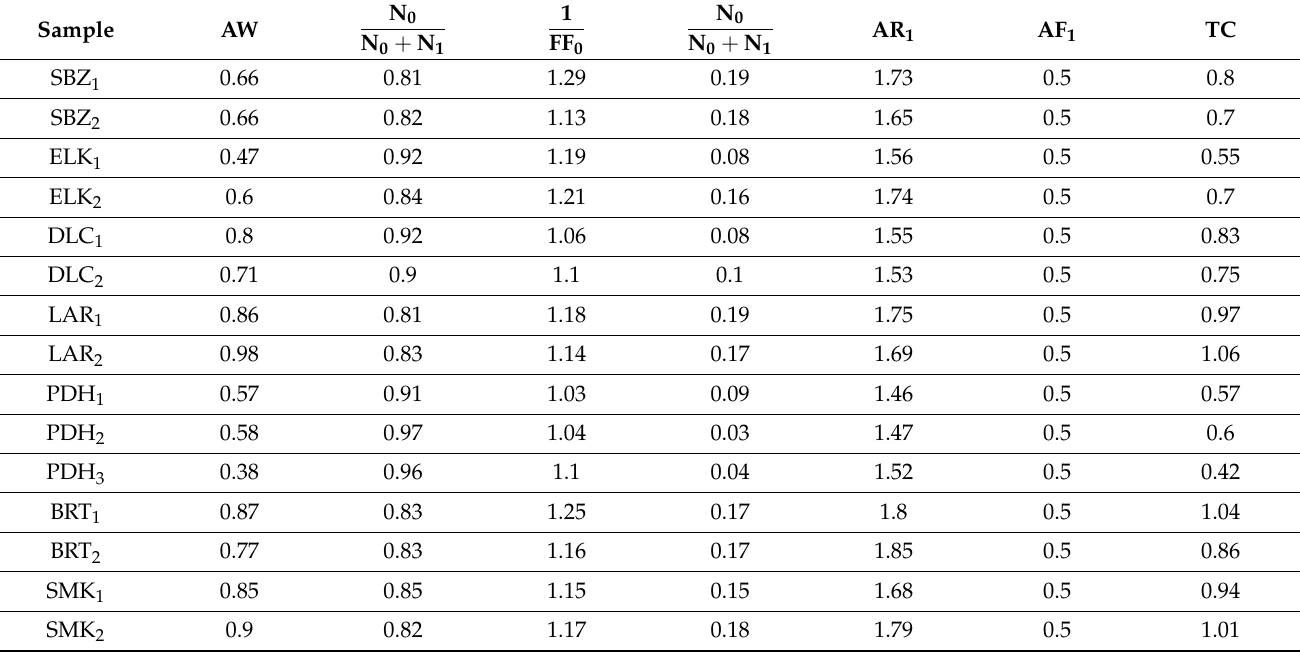
Table 4. Texture coefficient derivations for the rocks.